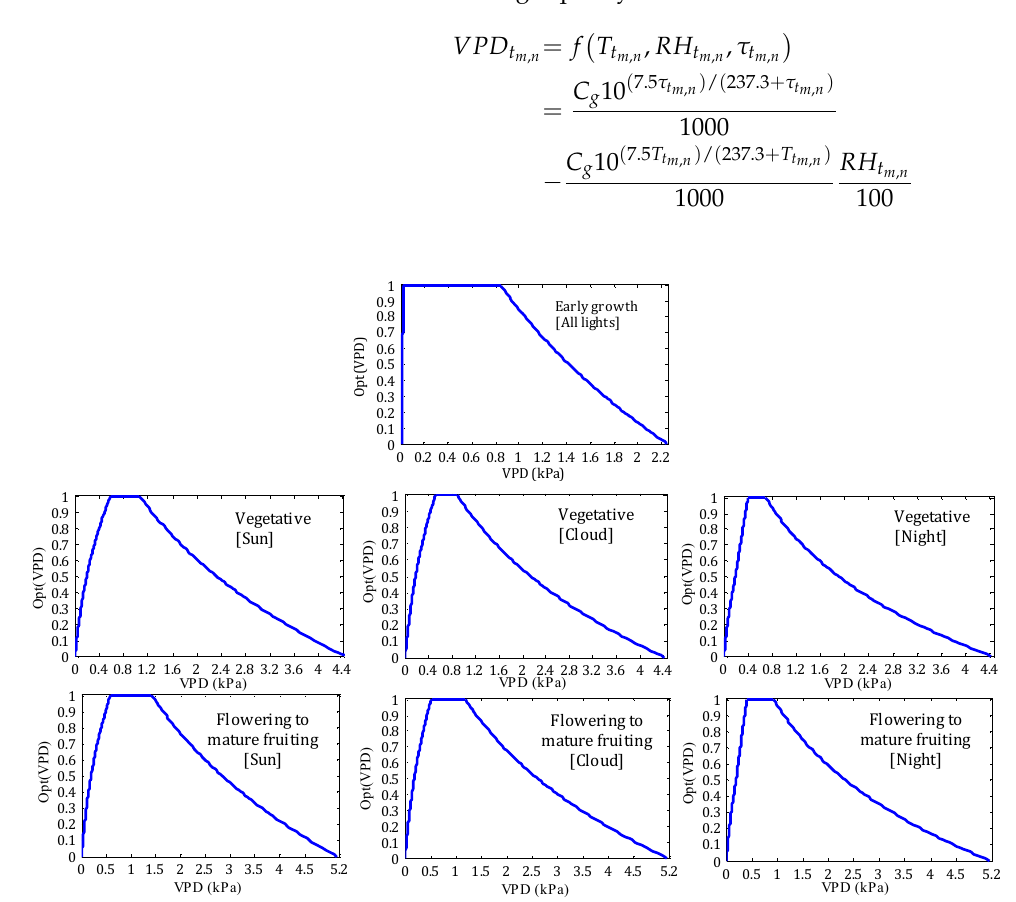
Figure 6. Membership functions for defining optimality degrees of vapor pressure deficit at different light condition and growth stages, reproduced from [40].